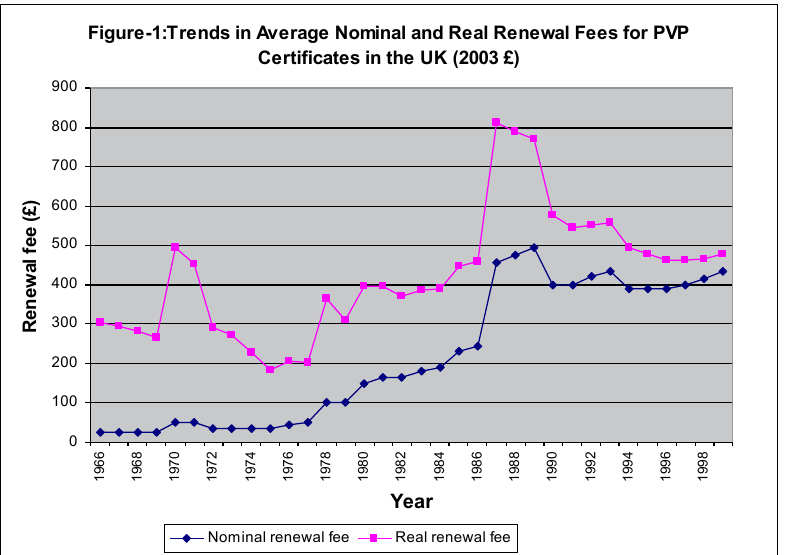
Figure 1. Trends in Average Nominal and Real Renewal Fees for PVP Certificates in the UK (2003 £)